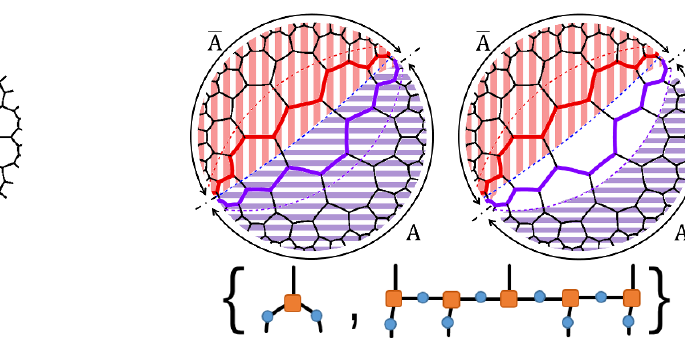
Figure 12 . The tensor network with f 7 ; 3 g tiling nh 1 i h 1 1 io and S c = ; . The boundary is divided 2 1 1 into two intervals A and (cid:22) A . Those tensors within the shaded region with purple (red) strips are absorbed by the greedy algorithm starting from A ( (cid:22) A ). The solid polyline in red denote a CP tensor chain. The red dashed curve is the CP curve (hypercircle); the blue dashed curve is its corresponding geodesic; the purple dashed curve is the re(cid:13)ection of CP curve with respect to the geodesic. An operator O in the interior is pushed to the boundary.